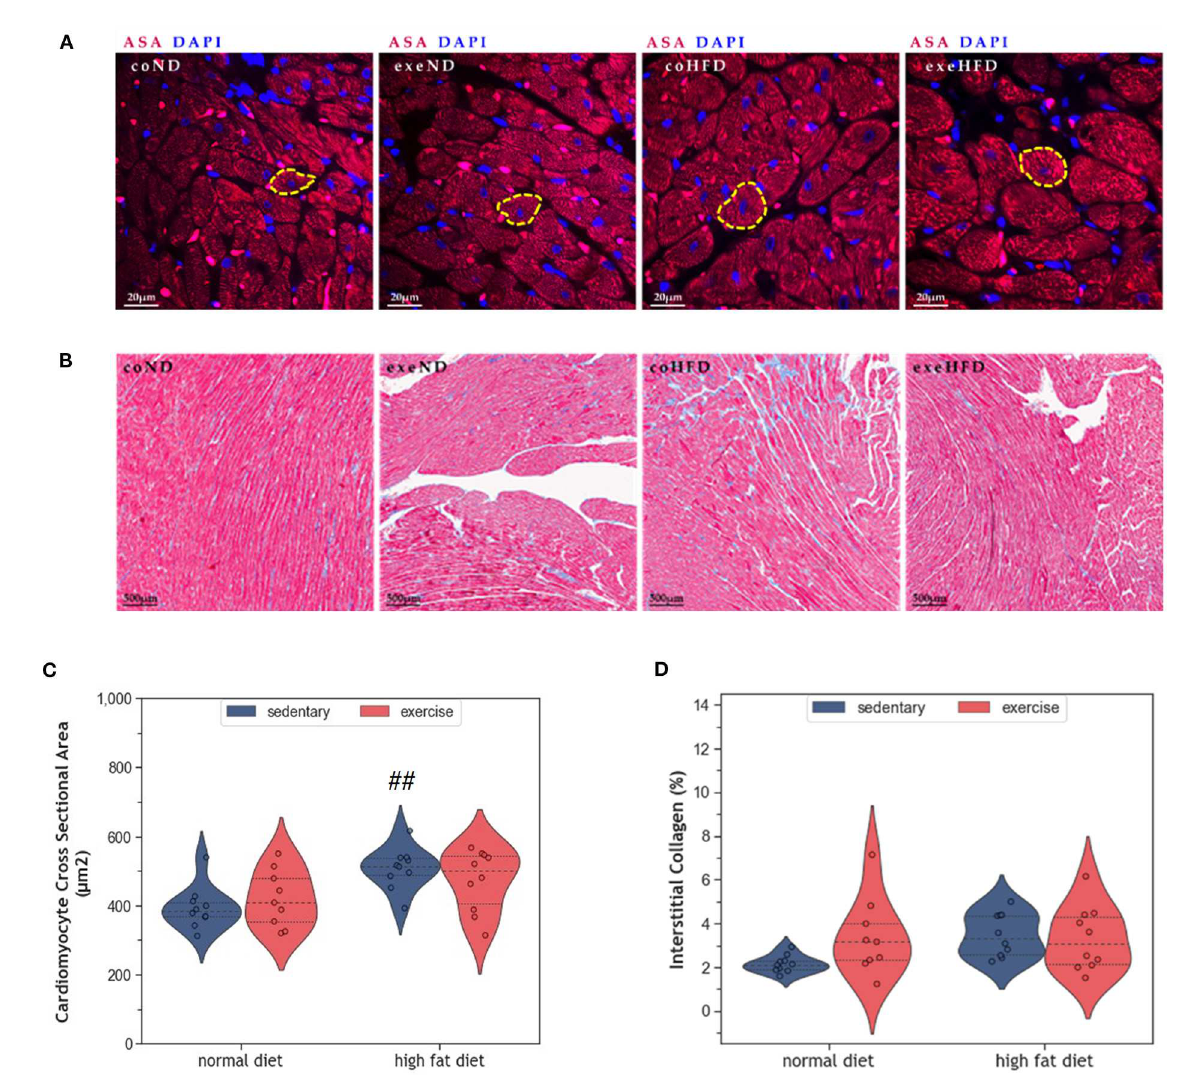
FIGURE2 (A) Representative histological images of left ventricular cardiomyocytes showing a greater CSA in HFD animals. The sections have been stained with fluorescent anti -Sarcomeric alpha Actin (ASA) antibody and 4 ′ ,6-diamidino-2-phenylindole (DAPI). (B) Representative histological images of left ventricular myocardial tissue showing comparable amounts of interstitial collagen. The slides have been stained with Masson Trichrome and Haematoxylin-Eosin. (C) Violin plot showing the distribution of CSA in the different experimental groups. (D) Violin plot showing the distribution of interstitial collagen (%) in the different experimental groups. From each experimental group 10 animals were selected for histomorphometry analysis. Statistical differences between groups were analyzed by two-way ANOVA with Sidak post-hoc tests for multiple comparisons. p values are only shown for pre-specified group comparisons. ## p < 0.01 compared to the sedentary normal diet